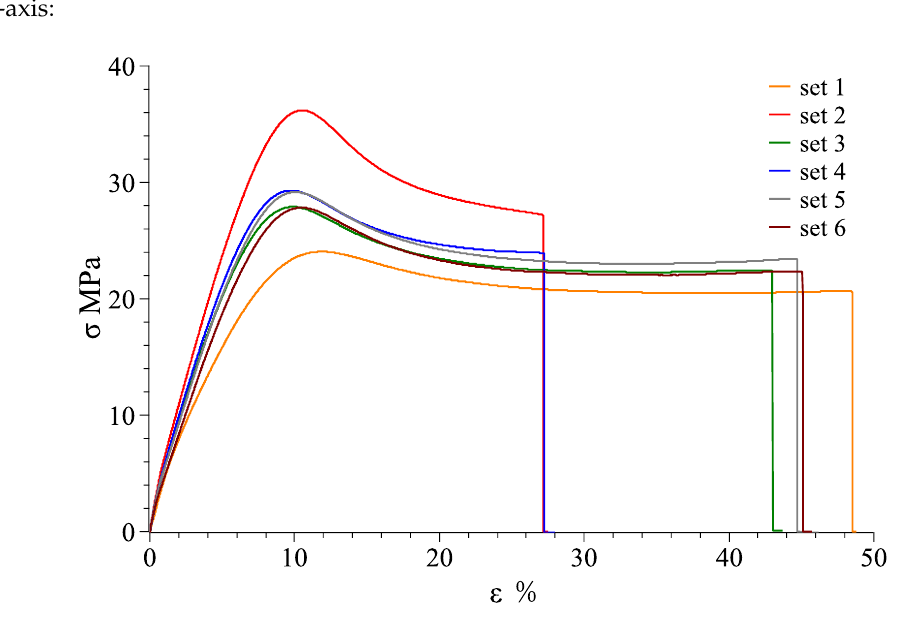
Figure A6. D8520, D8530 stress–strain curve for the Z-axis (6 specimens). Table A1. D8510, D8520 combination thermal-mechanical properties.